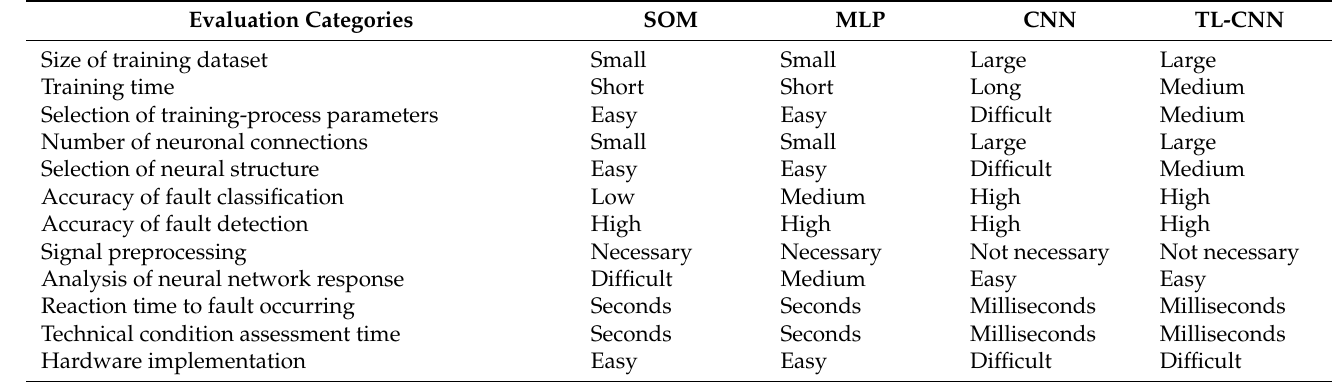
Table 3. Comparison of the neural network-based methods of PMSM fault